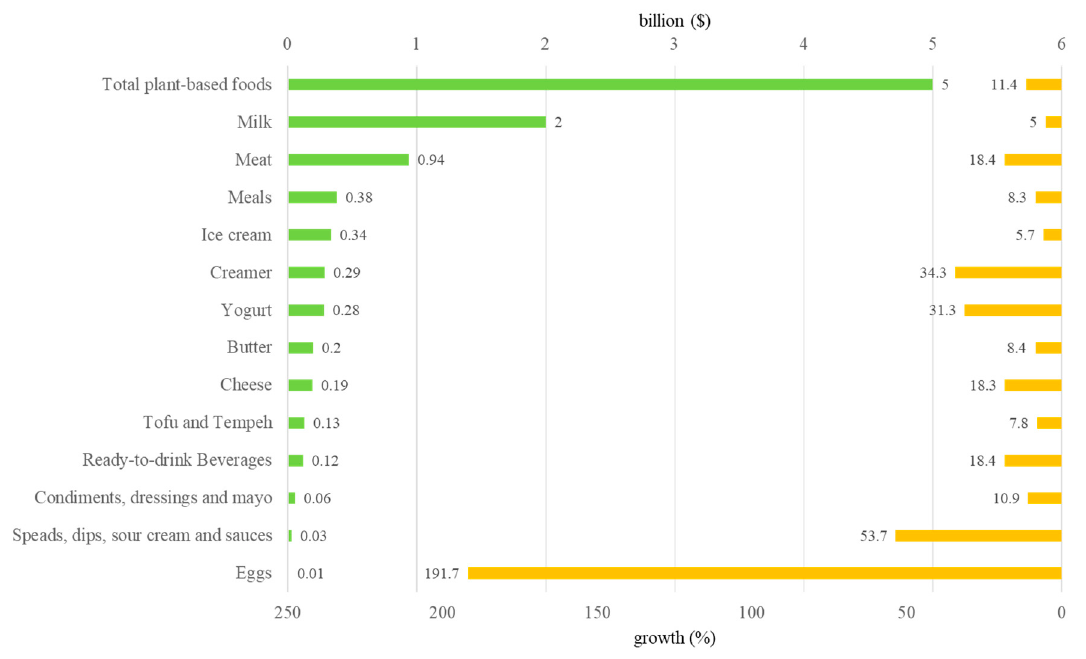
Figure 11. Growth of plant-based food substitutes by category.